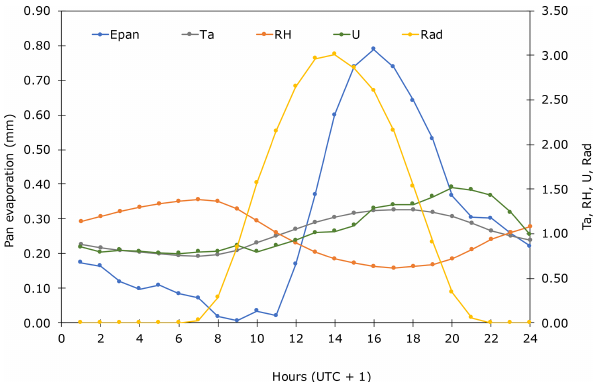
Figure 6. Mean daily cycle of pan evaporation ( E pan ) (left y axis) and normalised air temperature ( T a ), relative humidity (RH) of air, wind speed ( U ), and solar radiation (Rad) (right y axis) from June to September 2014 at Alquilha